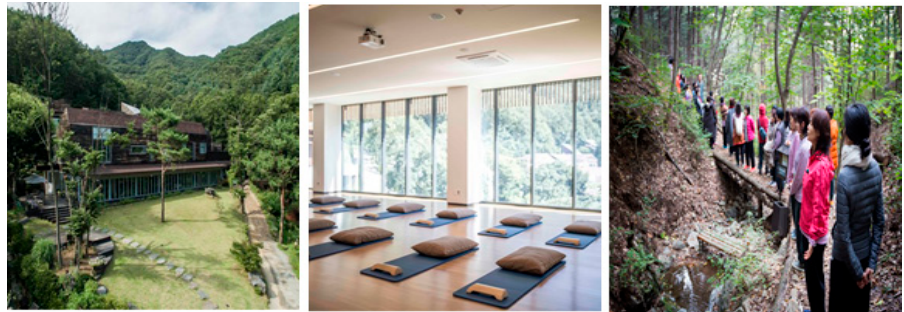
Figure 1. Forest site.